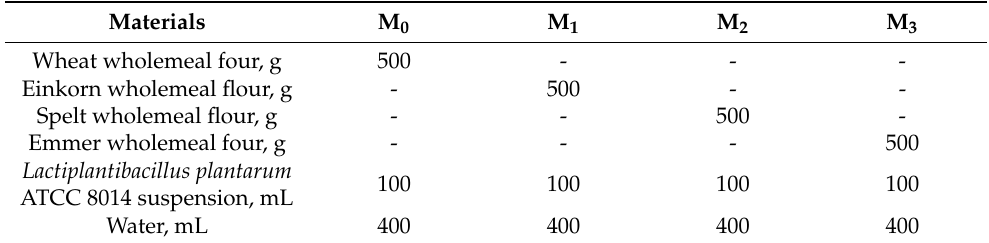
Table 1. Sourdough formulations for wheat, einkorn, spelt, and emmer flour and sample codifications. Materials M 0 M 1 M 2 M 3 Wheat wholemeal four, g